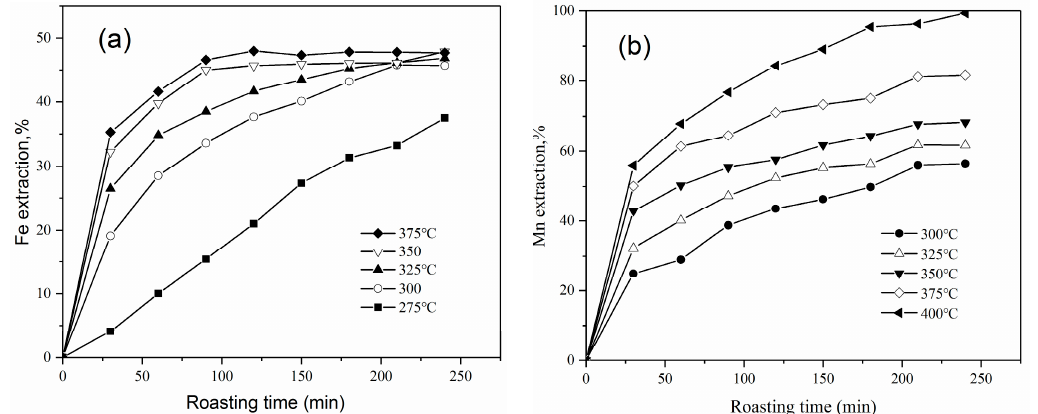
Figure 3. The effect of roasting temperature on ( a ) iron and ( b ) manganese with sulphating roasting-water leaching.